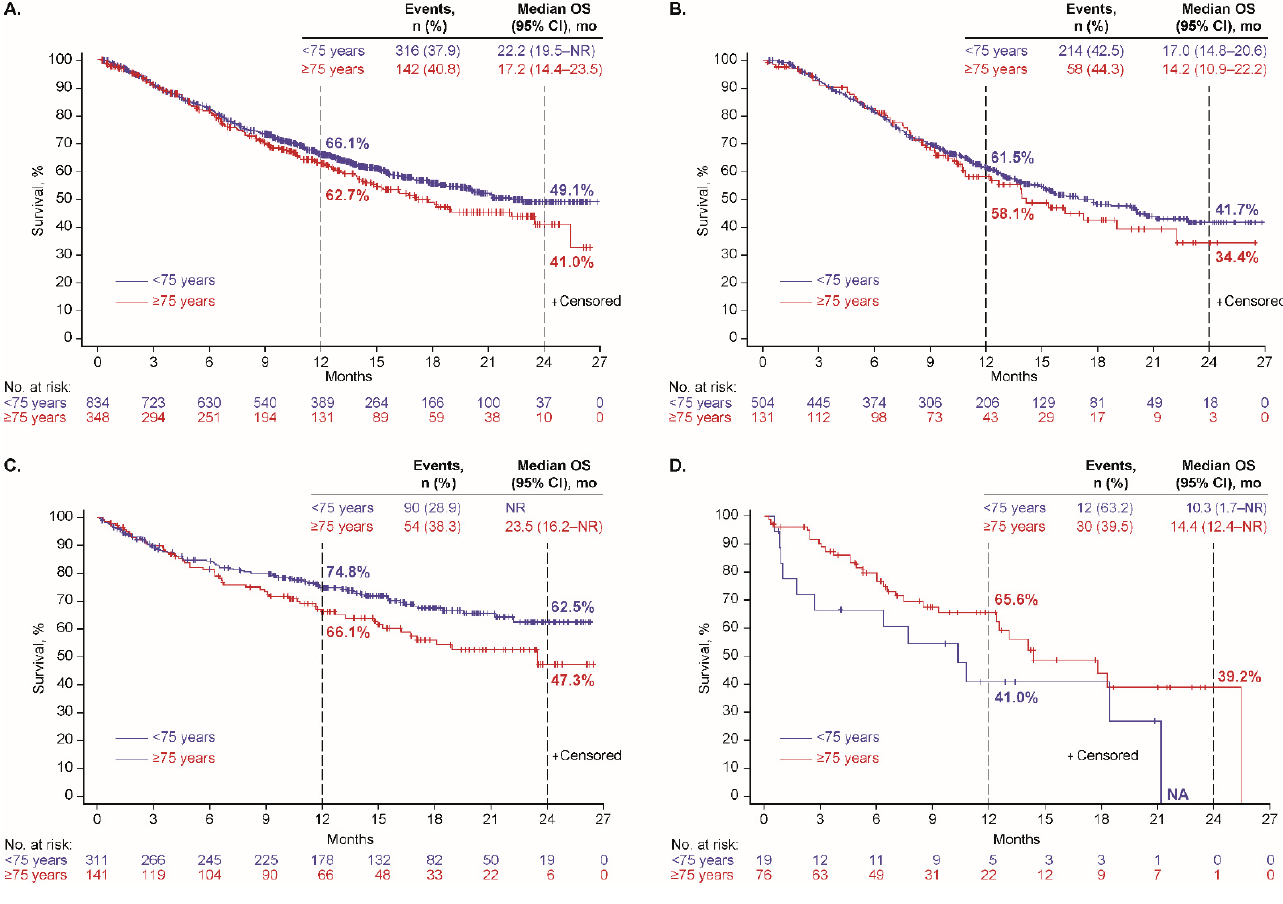
Figure 2. Overall survival by age group among patients who received first-line therapy ( A ) overall and with ( B ) platinum doublet, ( C ) ICI monotherapy, and ( D ) nonplatinum cytotoxic regimen. Table 3. Subsequent systemic therapy regimens by treatment